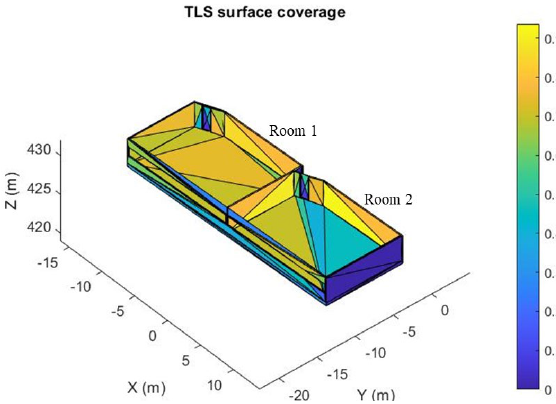
Figure 7 . Closest point distances between the iPad Pro and the TLS point cloud.